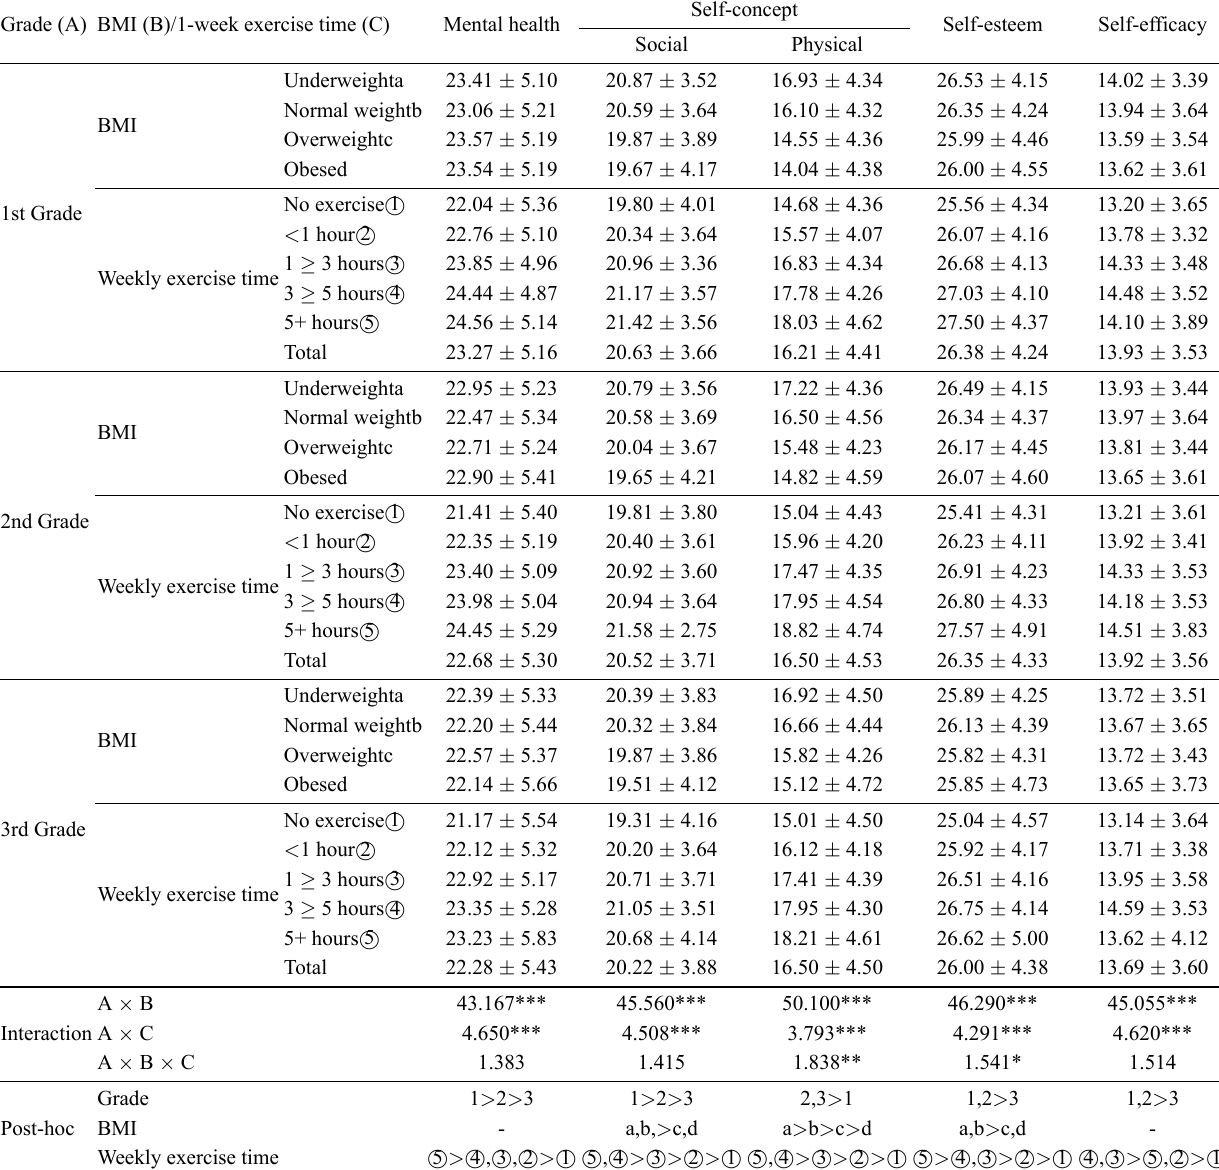
Table 2. Analysis of psychological health differences due to BMI and weekly exercise